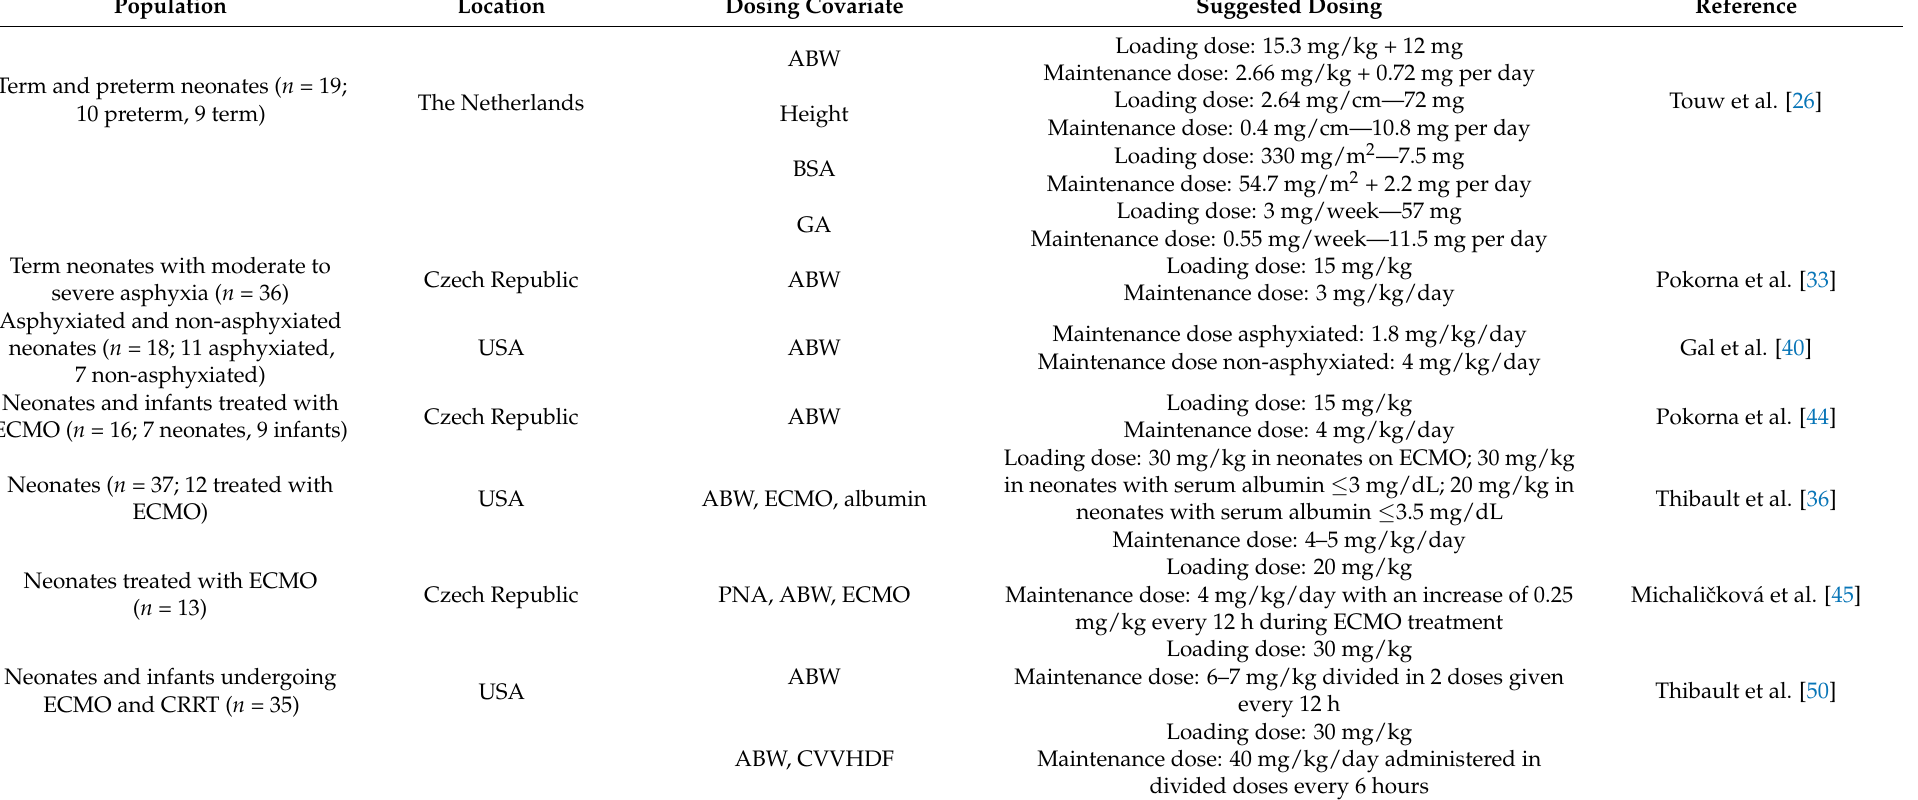
Table 2. Suggested phenobarbital dosing based on covariates of the pharmacokinetic